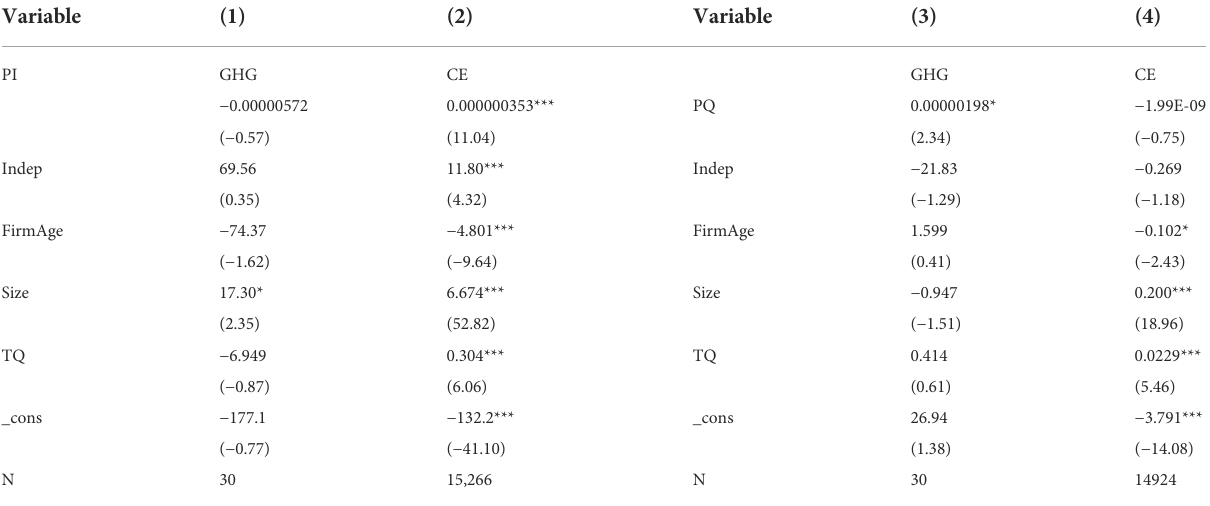
TABLE 3 Regression results of enterprise carbon emission and greenhouse gas emission reduction on products.